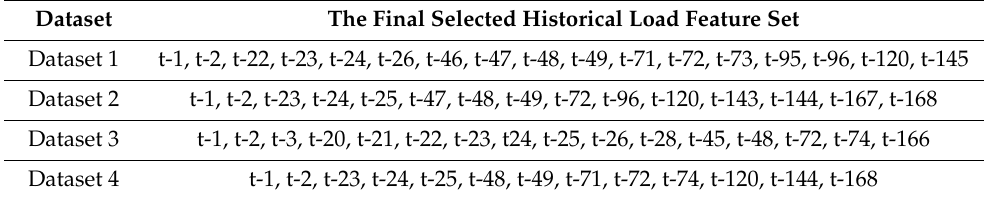
Table 4. The final feature selection result of four datasets.